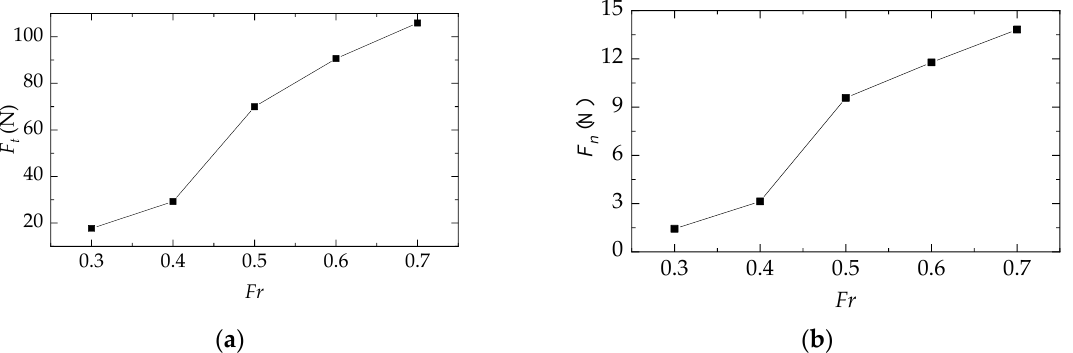
Figure 14. Force component at varying velocities at the center of buoyancy. ( a ) The tangential component of resistance. ( b ) The normal component of resistance.